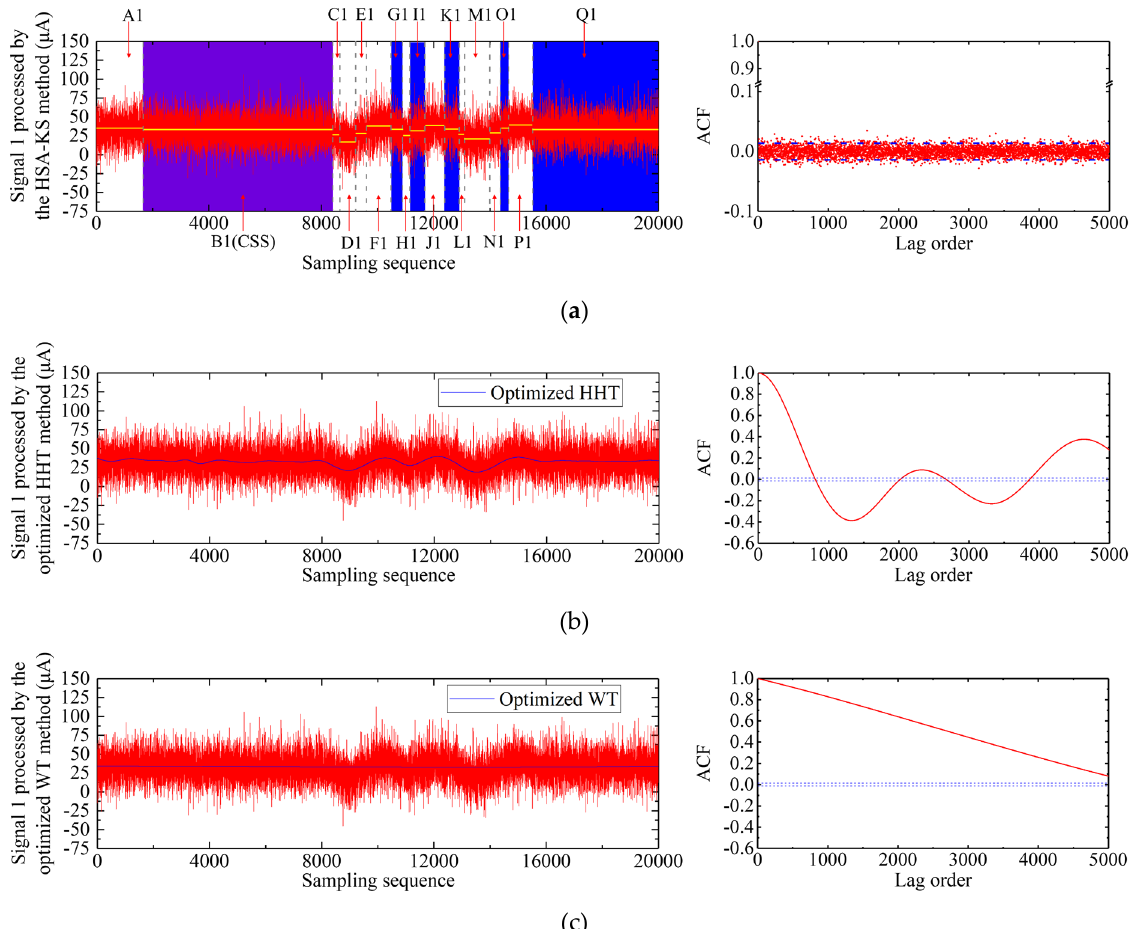
Figure 5. Results of signal 1 processed using the three different schemes: ( a ) HSA-KS method; ( b ) optimized HHT method; ( c ) optimized WT method.